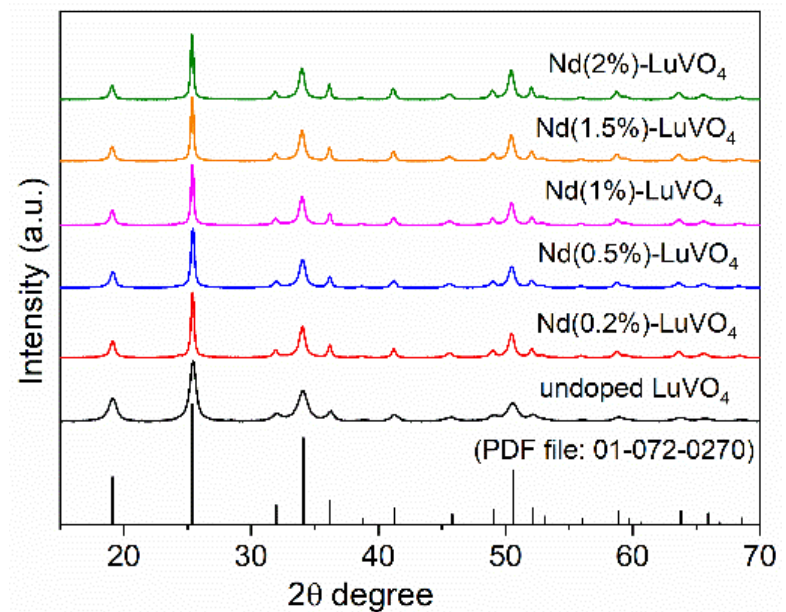
Figure 2. X-ray diffraction patterns for the nanoparticles obtained in the absence (undoped) and the presence of different amounts of Nd 3+ , and PDF of tetragonal LuVO 4 .